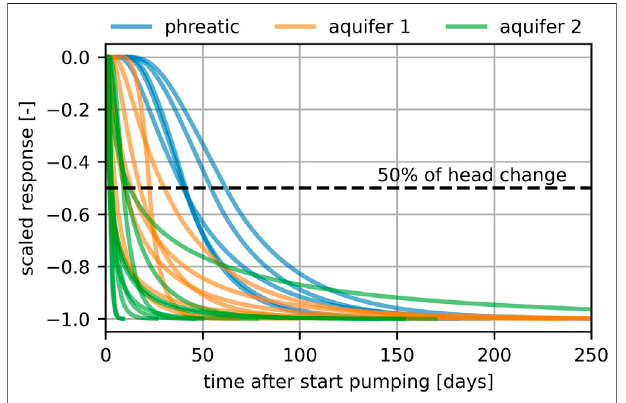
FIGURE 7 | Scaled step responses for well fi eld Hemmen, categorized per aquifer.